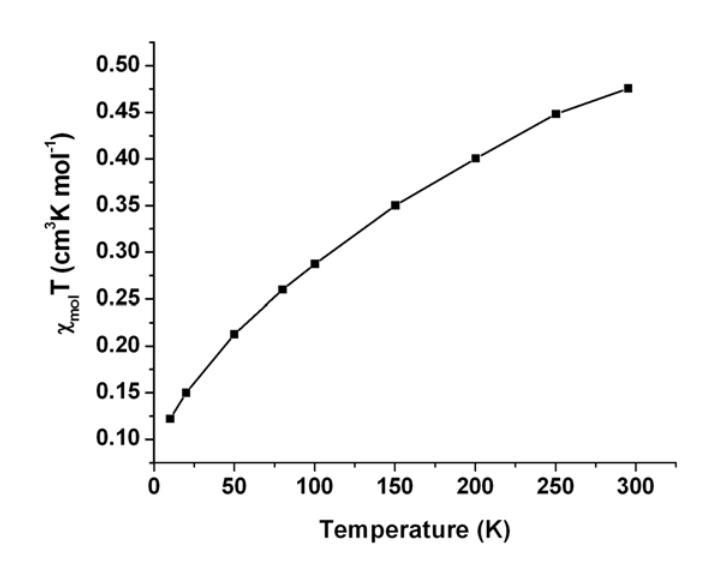
Fig. 7 χ mol T vs T plot for complex 3.